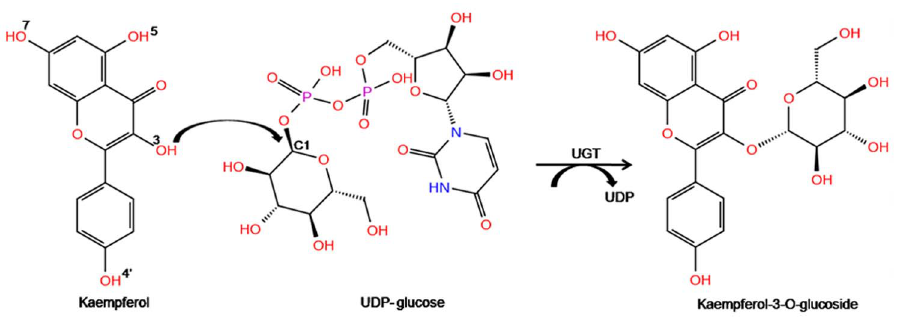
Figure 1. Reaction mechanism of UGT. Reaction catalyzed by UGT is shown with Kaempferol and UDP-glucose as substrates that react to form Kaempferol-3-O-glucoside along with the release of UDP moiety. The numbering of the OH groups- 7-OH, 5-OH, 3-OH and 4 9 -OH in flavonoids is shown.